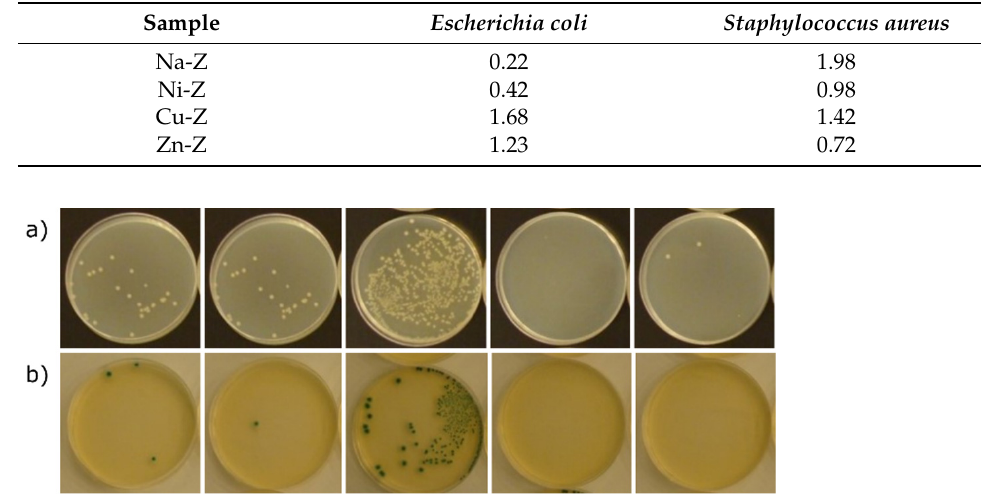
Figure 6. Growth of Escherichia coli on PCA ( a ) and TBX ( b ) media after culturing the suspension samples recovered from the test materials after 24 h of incubation under optimal growth conditions. From left to right: perlite, Na-Z, Ni-Z, Cu-Z, and Zn-Z.